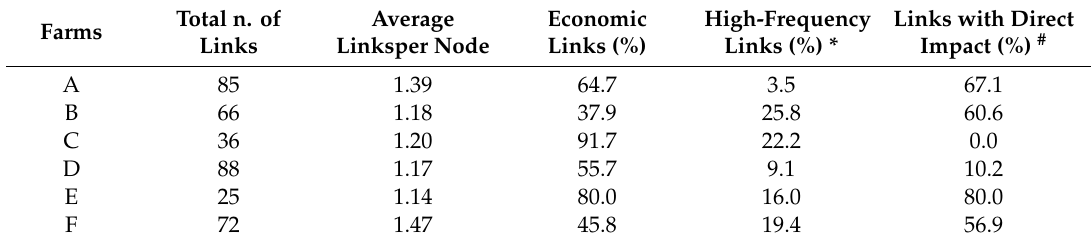
Table 4. The number of links, average links per node, and % of economic links, high-frequency links, and links with a direct impact on the persons with mental issues (time point: T0).